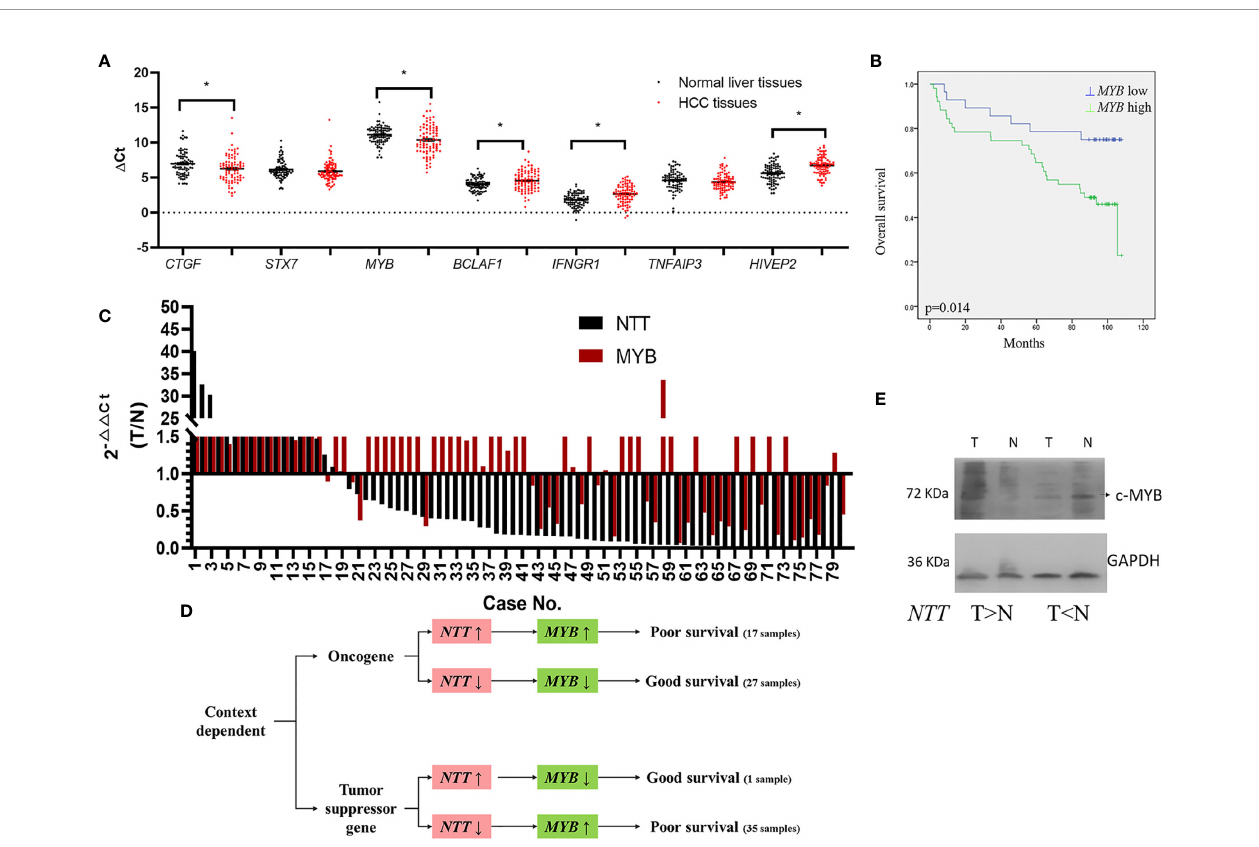
FIGURE 2 | Genes near NTT are dysregulated in HCC. (A) Expression of CTGF , STX7 , MYB , BCLAF1 , IFNGR1 , TNFAIP3 , and HIVEP2 was evaluated by qPCR in HCC. (B) High MYB expression indicated a poor clinical outcome. * p < 0.05. (C) Log2 fold changes in NTT and MYB expressions (T/N) of each case are plotted. (D) The roles of NTT for MYB is context dependent. (E) MYB protein expression in HCC tissue samples. Left pair was MYB increased in HCC; right pair was MYB decreased in